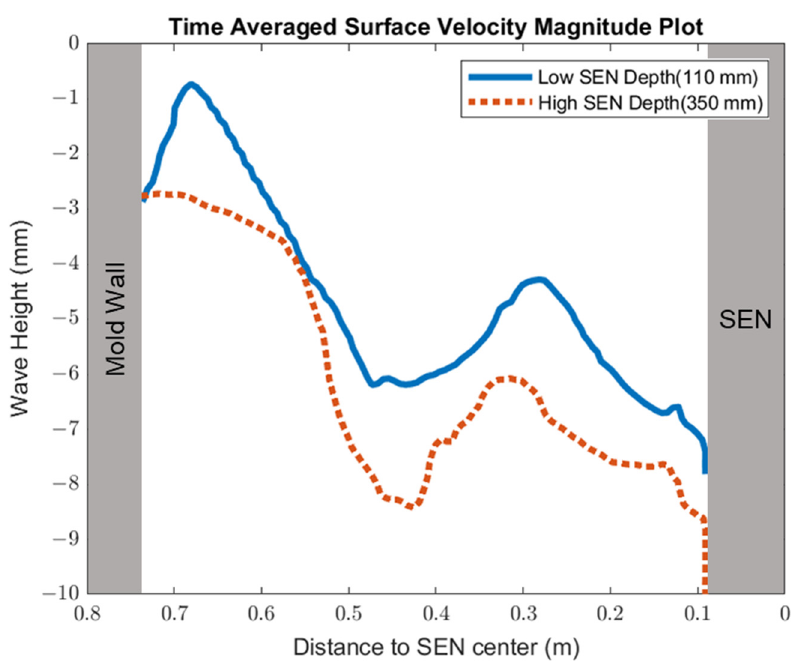
Figure 14. Low SEN depth (Case 4) vs. high SEN depth (Case 8) standing wave comparison.